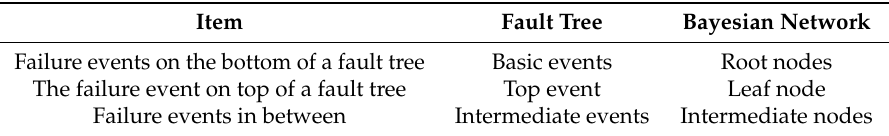
Table 1. Relation between nodes and failure events.